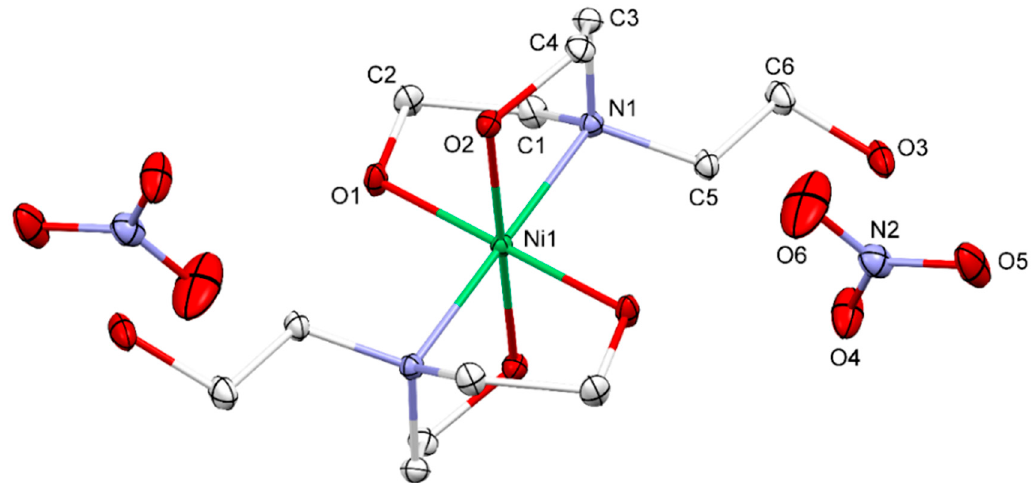
Figure 1. Molecular structures of the Ni-TEA complex with principal atom labels.